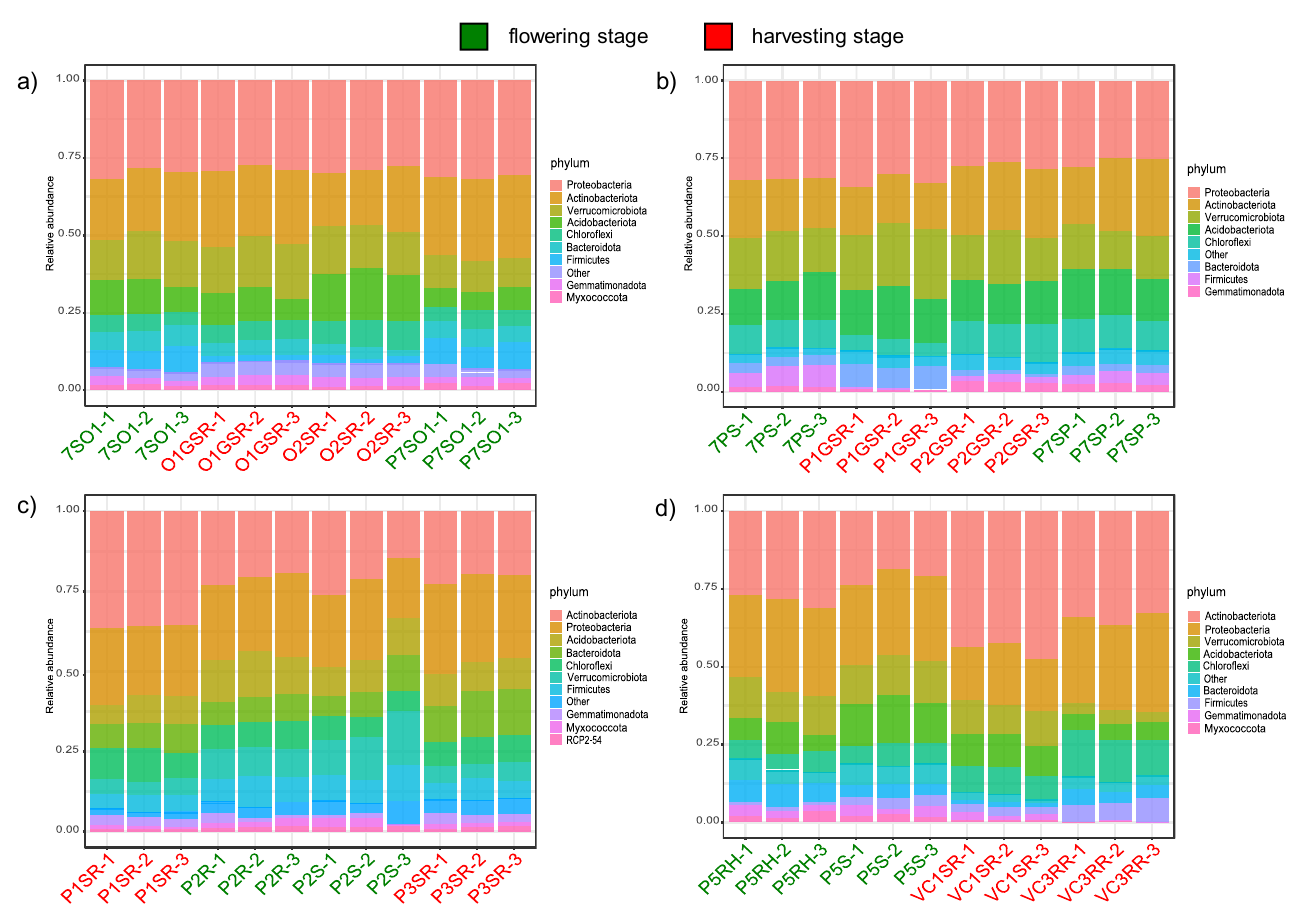
Figure 4. Relative abundances of bacterial phyla in the potato bacterial rhizomicrobiota. The four localities are shown separately. Samples from flowering and harvesting stages are indicated. See Table S1 for sample codes. ( a ) Gavigno 1. ( b ) Gavigno 2. ( c ) Prato. ( d ) Val di Chiana.